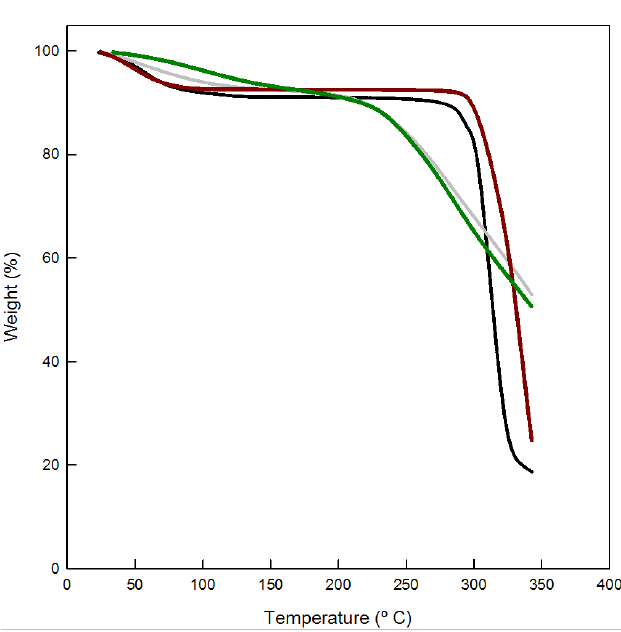
Figure 4. Thermograms for the different samples analyzed (black: γ–CDs, red: HP–γ–CDs, grey: γ–CDs–EPI, green: HP–γ–CDs–EPI).